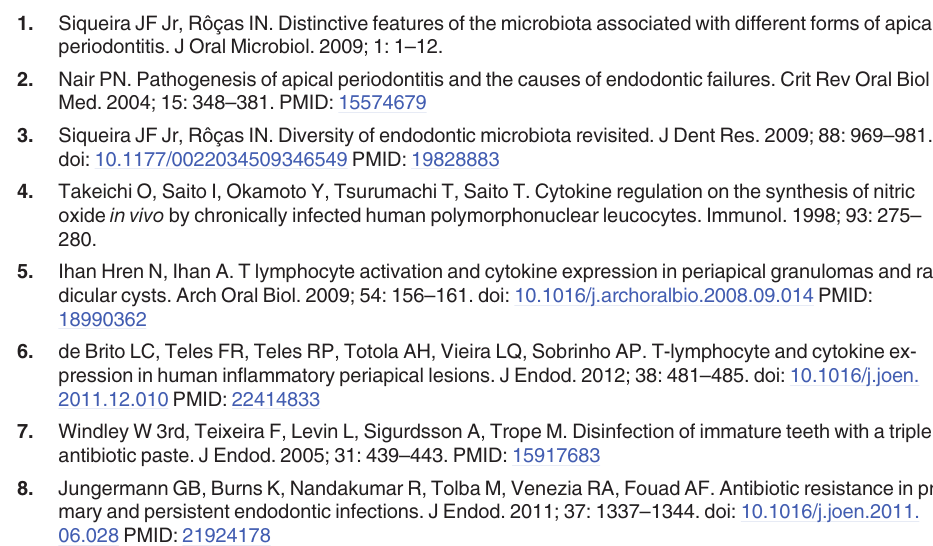
specimen was calculated using the standard curve. The median of EBV DNA copies in periapi- cal granulomas was approximately 8688.01 per 1 μ g of total DNA, as shown by a horizontal bar. (cid:1) showed statistical difference using Mann-Whitney U test ( p = 0.0001). S4 Fig. Detection of EBER using in situ hybridization. (A-F) In situ detection of EBER-ex- pressing cells in periapical granulomas (6 out of 9) was shown in the cytoplasm and nuclei of B cells (arrows) and plasma cells (arrow heads). (G-I) Three periapical granulomas showed EBER-negative expression. (J) Healthy gingival tissues never showed positive expression. Scale bar = 50 μ m. S5 Fig. LMP-1 immunohistochemistry using serial sections of periapical granulomas. Framed boxes in left panels (A, C, E) were magnified to right panels (B, D, F, respectively). (A, B) LMP-1 immunohistochemistry showed positive staining in B cells (arrows) and plasma cells (arrow heads). (C, D) EBER-expressing cells were present at the same area of LMP-1-express- ing cells. (E, F) A negative control using normal mouse IgG antibody did not exhibit LMP-1 ex- pression. Scale bar = 50 μ m. S1 Table. Detection of EBV DNA using quantitative real-time PCR. Periapical granulomas and healthy gingival tissues were analyzed to detect EBV DNA by quantitative real-time PCR. EBV DNA were highly detected from periapical granulomas in comparison with healthy gingi- val tissues. (cid:1) Mann-Whitney U